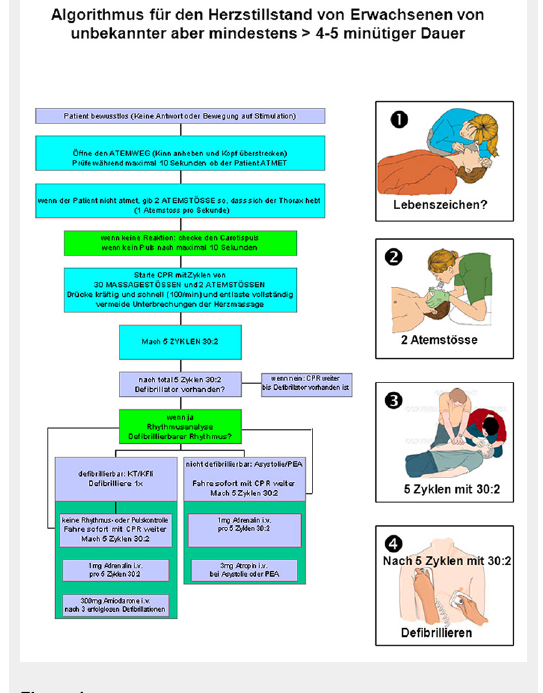
Kaplan-Meier diagram displaying the probability of completing the first resuscitation cycle consisting of 30 compressions and 2 ventilations over time. Teams were randomized to apply either ABC or CAB as initial approach to CPR. Time 0 is defined as first touch of the patient by one of the rescuers. Curves differ significantly (log- rank